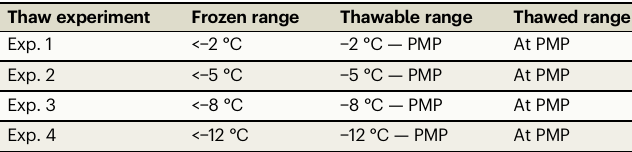
Table 1 | Basal temperature ranges de fi ned for each thaw experiment Thaw experiment Frozen range